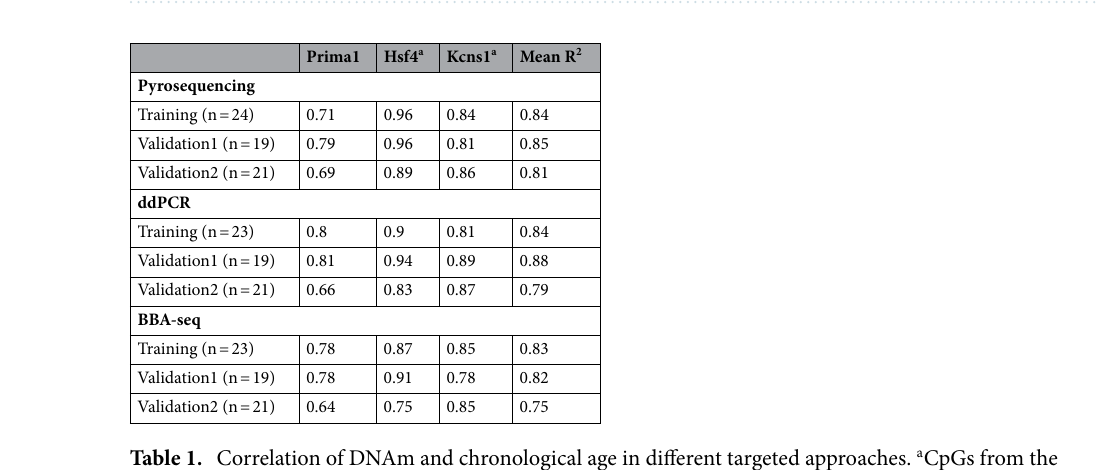
Figure 2. Three CpG epigenetic clock for mice based on droplet digital PCR. Age-associated DNAm was measured with ddPCR at 3 CpGs in the genes Prima1 ( a ), Hsf4 ( b ) and Kcns1 ( c ) in the training set (n = 23) and two independent validation sets (n = 21 and 19) of C57BL/6 mice. ( d ) The measurements of the training set were used for a multivariable model for epigenetic age predictions. Coefficients of determination (R 2 ) of DNAm versus chronological age and median errors (weeks) are demonstrated.